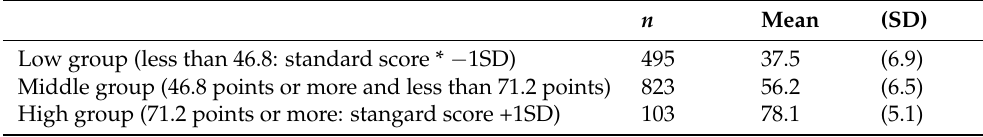
Table 1. Sense of coherence classification in this study based on Japanese representative sample.